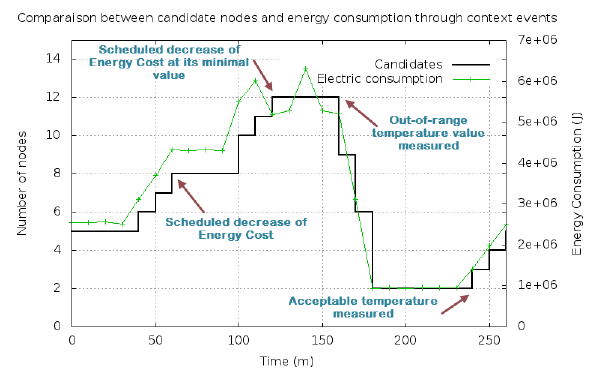
Figure 11: Evolution of DIET’s candidate nodes in relation with energy consumption reported by